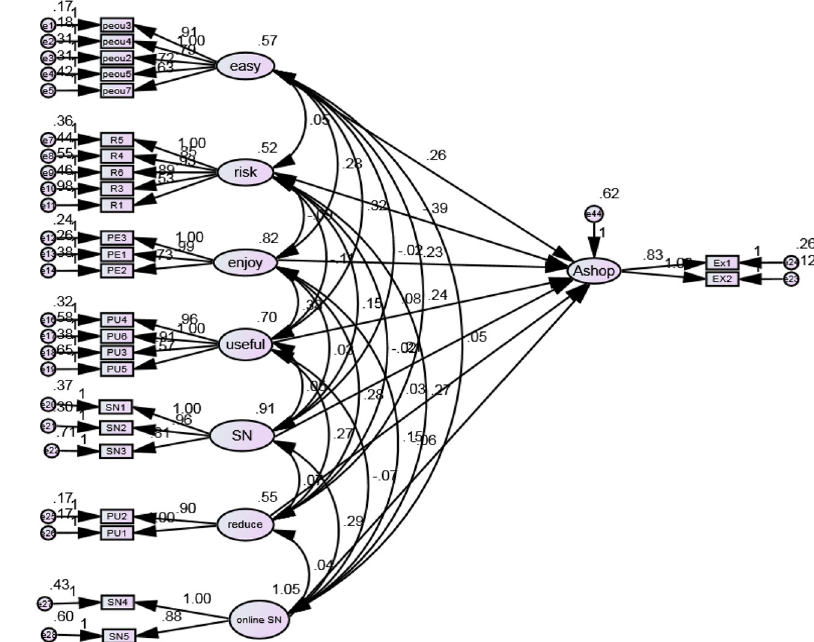
Figure 1. The initial structural model including all proposed factors in fl uencing the actual online shopping